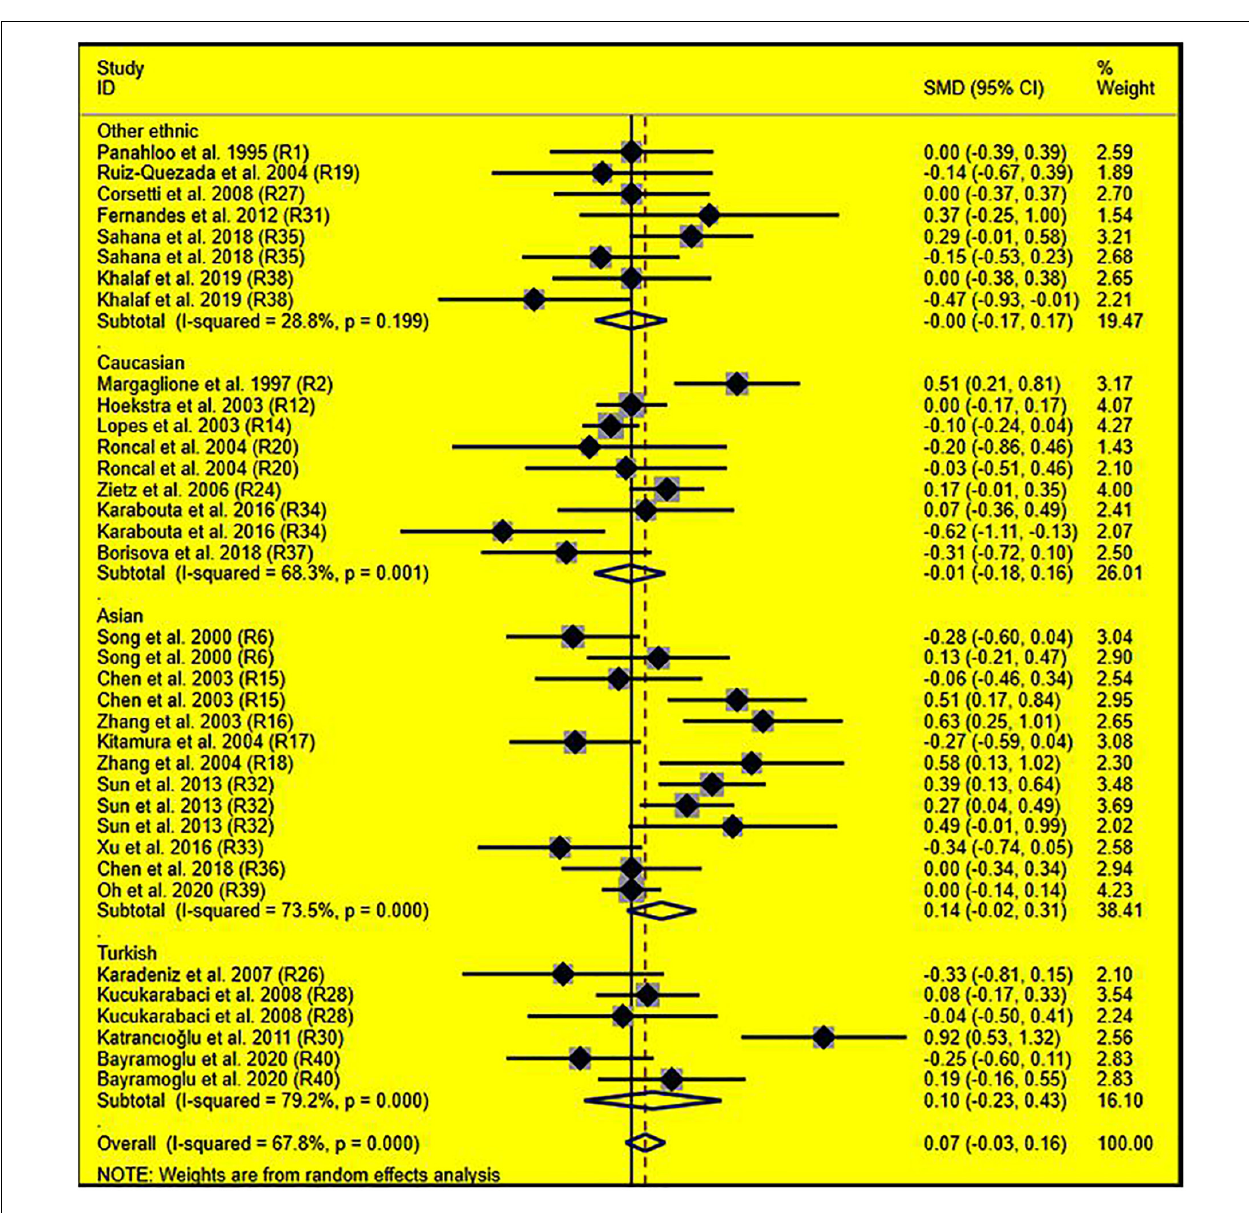
FIGURE 5 | Forest plot of the meta-analysis between SERPINE1 rs1799889 polymorphism and circulating HDL-C